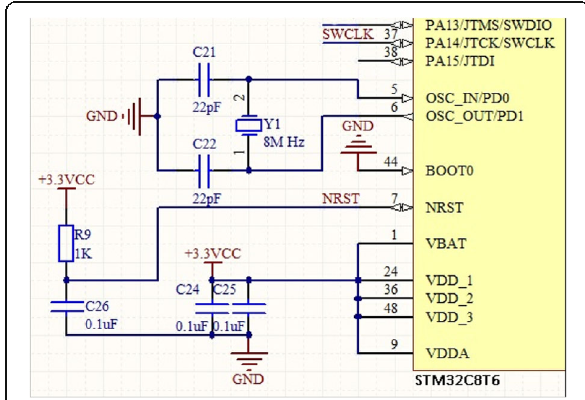
Fig. 20 The minimum system circuit of a single-chip